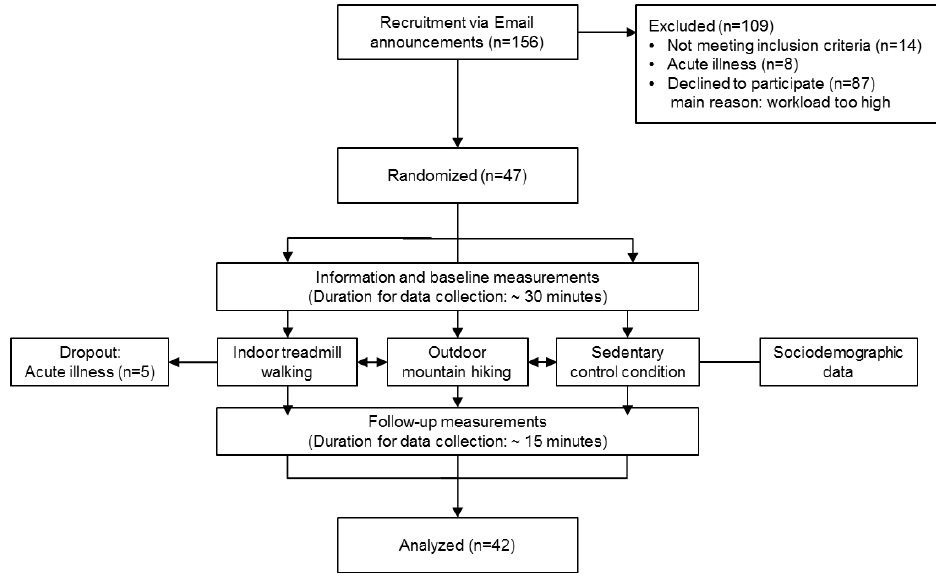
Figure 1. Flow diagram for data collection and participant flow. All participants were exposed to the three experimental conditions in a randomized order. The cases of acute illness occurred after the sedentary control condition (n = 2) and after indoor treadmill walking (n = 3).